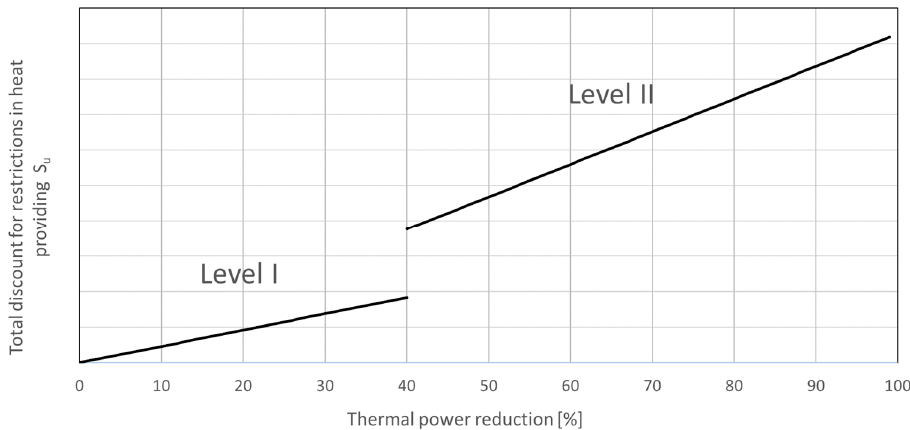
Figure 3. The general dependence of the number of discounts on the size of the restriction in the heat providing to recipients.